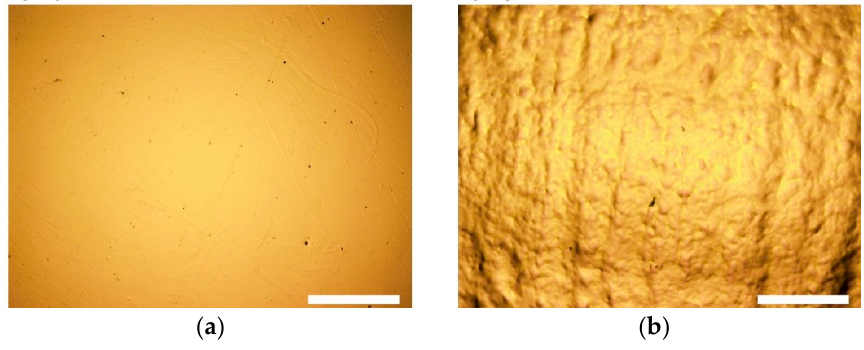
Figure 1. Typical microscopic images of ( a ) non-processed (control) and ( b ) laser-processed gel surfaces. The roughness of the gel surface is larger at the laser-processed gel surface than at the non-processed one. Scale bars represent 500 μ